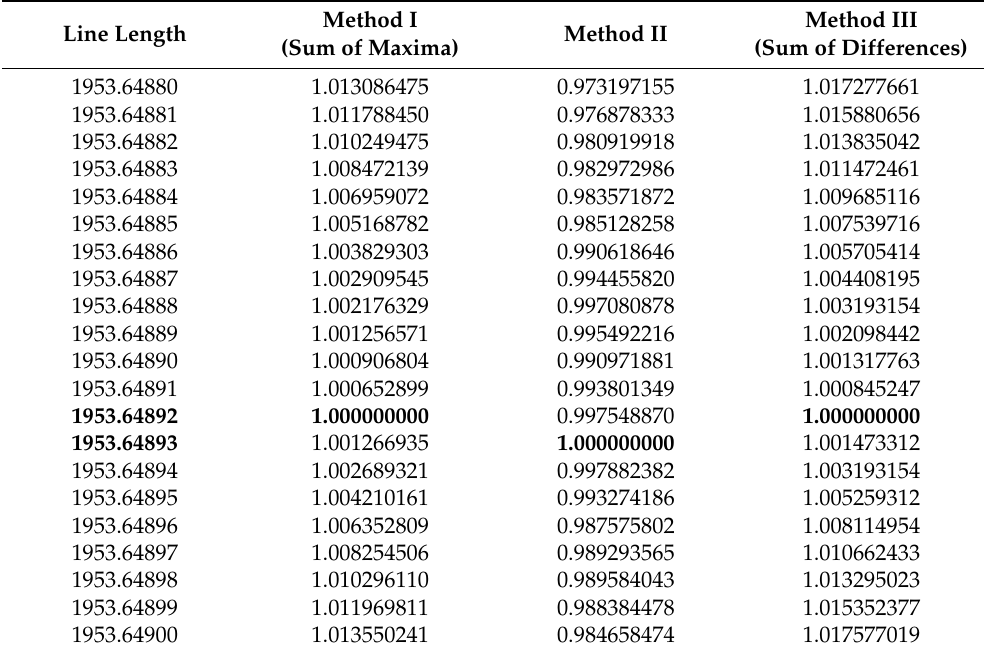
Table 8. Image line length estimation results for the accuracy ∆ =